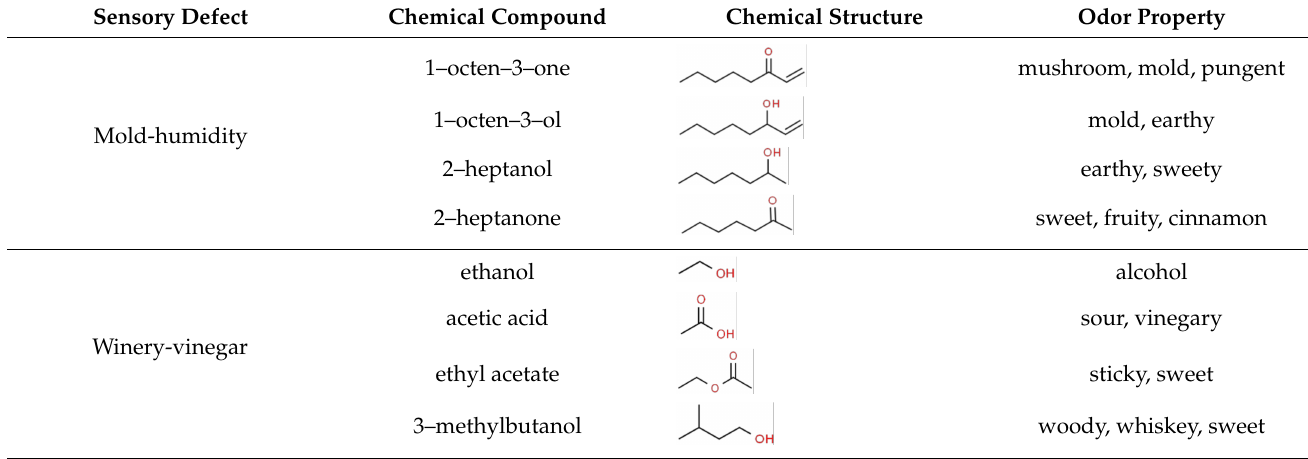
Table 2. Some of the chemical compounds responsible for the main sensory defects detected in VOO and their odor descriptors. Sensory Defect Chemical Compound Chemical Structure Odor Property